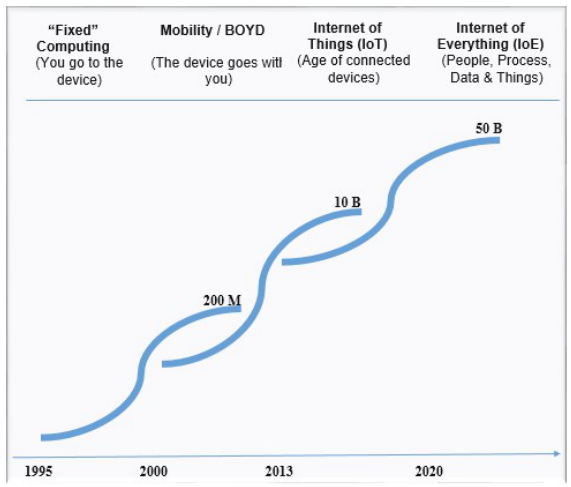
Figure 5. Internet growth is occurring in S-curve waves [9,12].